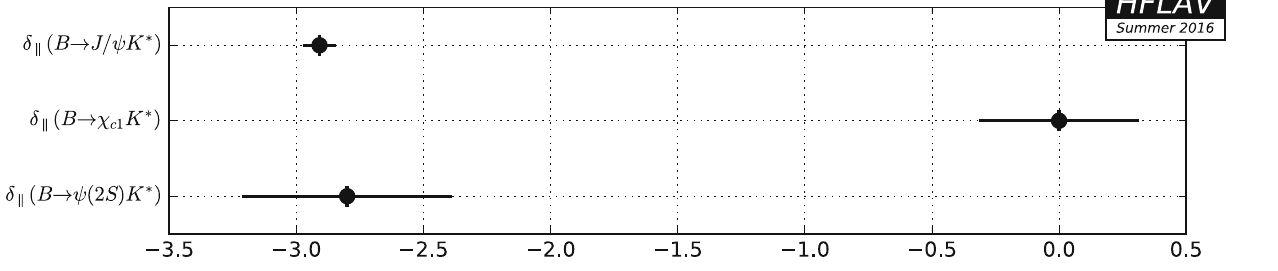
Fig. 149 Summary of the averages from Table 183